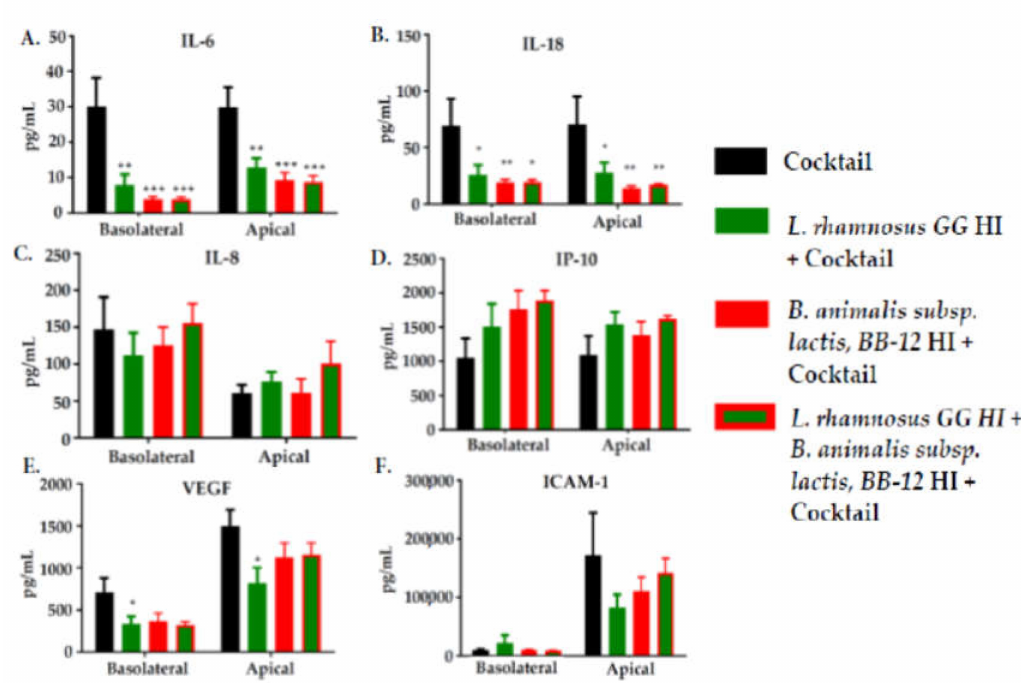
Figure 6. Concentrations (pg / mL) of IL-6 ( A ), IL-18 ( B ), IL-8 ( C ), IP-10 ( D ), VEGF ( E ), and sICAM-1 ( F ) in the basolateral and the apical medium of Caco-2 cells incubated on the apical side with heat-inactivated (HI) L. rhamnosus GG , B. animalis subsp. lactis, BB-12 or their combination for 24 h prior to 24 h treatment with an inflammatory cocktail on the basolateral side. L. rhamnosus GG was heat-inactivated for 3 min at 70 ◦ C, while B. animalis subsp. lactis, BB-12 was heat-inactivated for 6 min at 62.3 ◦ C. Data are mean + SEM (n = 9). One-way ANOVA p value 0.0003 (IL-6 both basolateral and apical), 0.012 (IL-18 basolateral), 0.008 (IL-18 apical), 0.05 (VEGF basolateral), 0.07 (VEGF apical), > 0.15 (all others). * p < 0.05, ** p < 0.01, *** p < 0.001 vs. cocktail